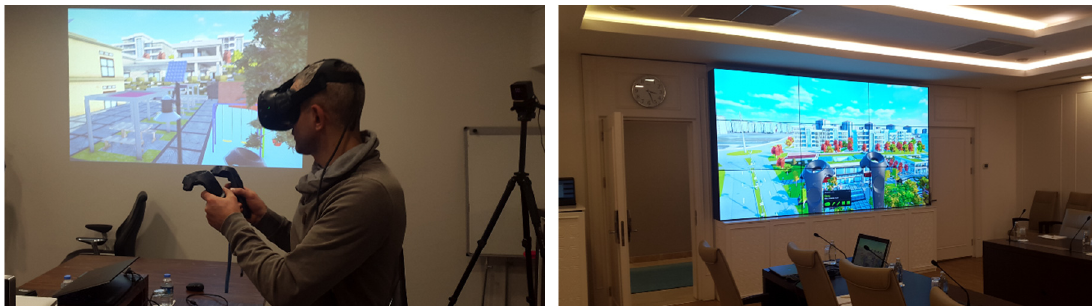
Figure 21. Unity simulation of the LoD3 future city model generated in the study.